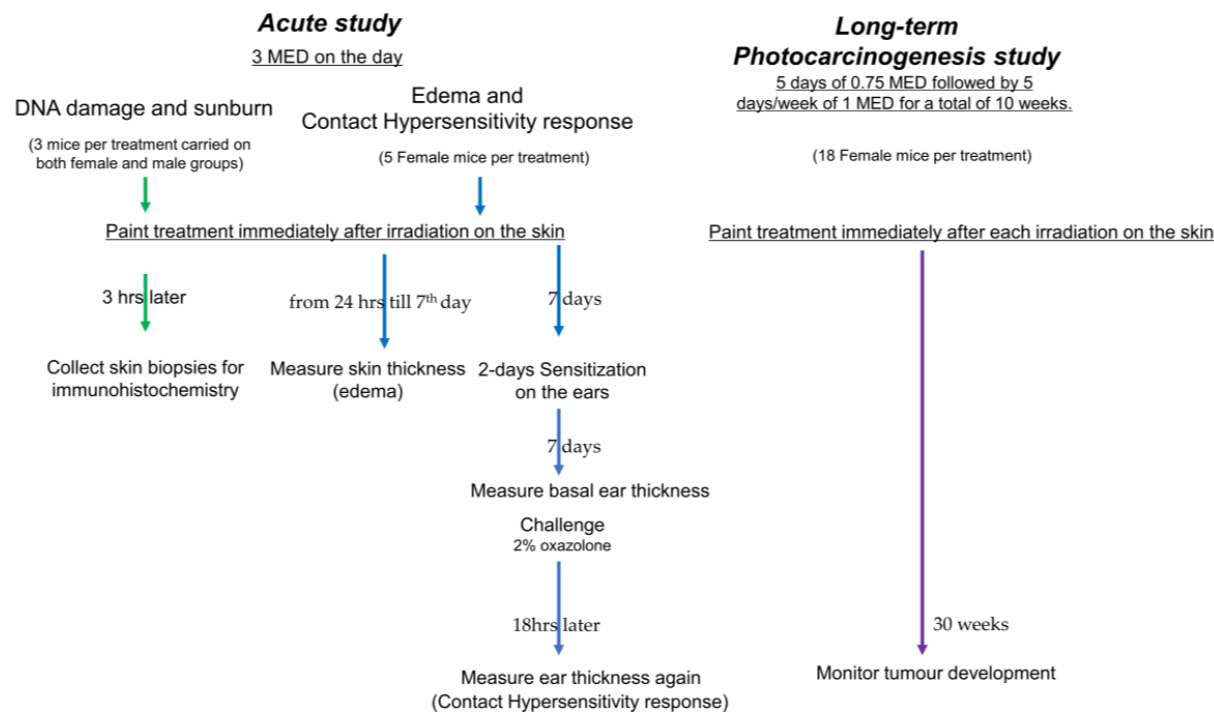
Figure 5. Experimental design scheme.